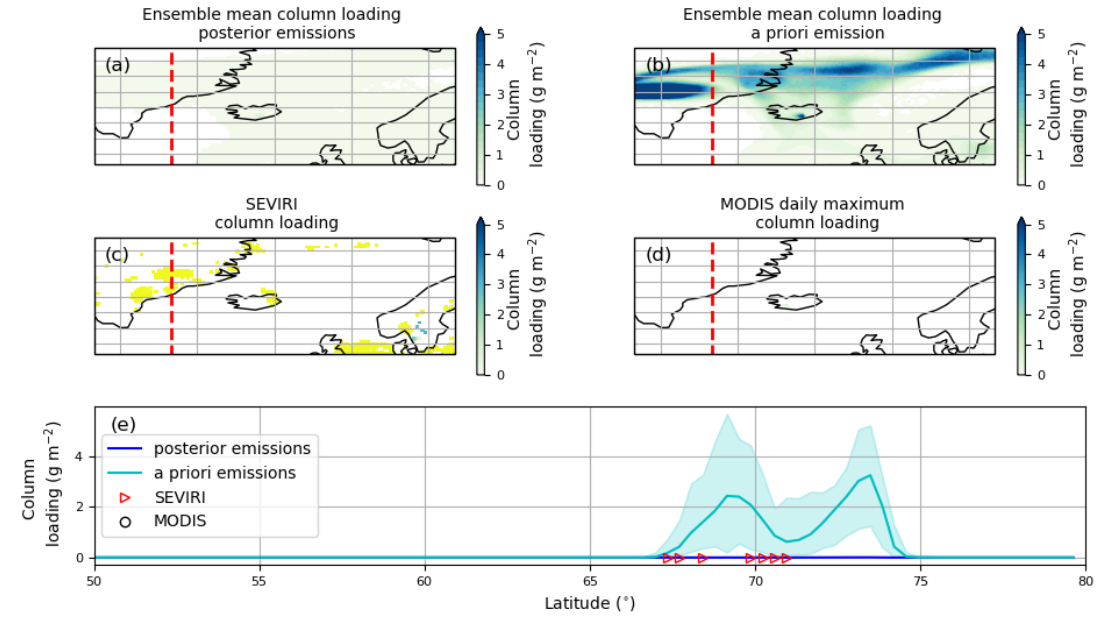
Figure 9. As Figure 8 for 0000 UTC on 25 May 2011. Note MODIS (panel d) did not retrieve any ash on this